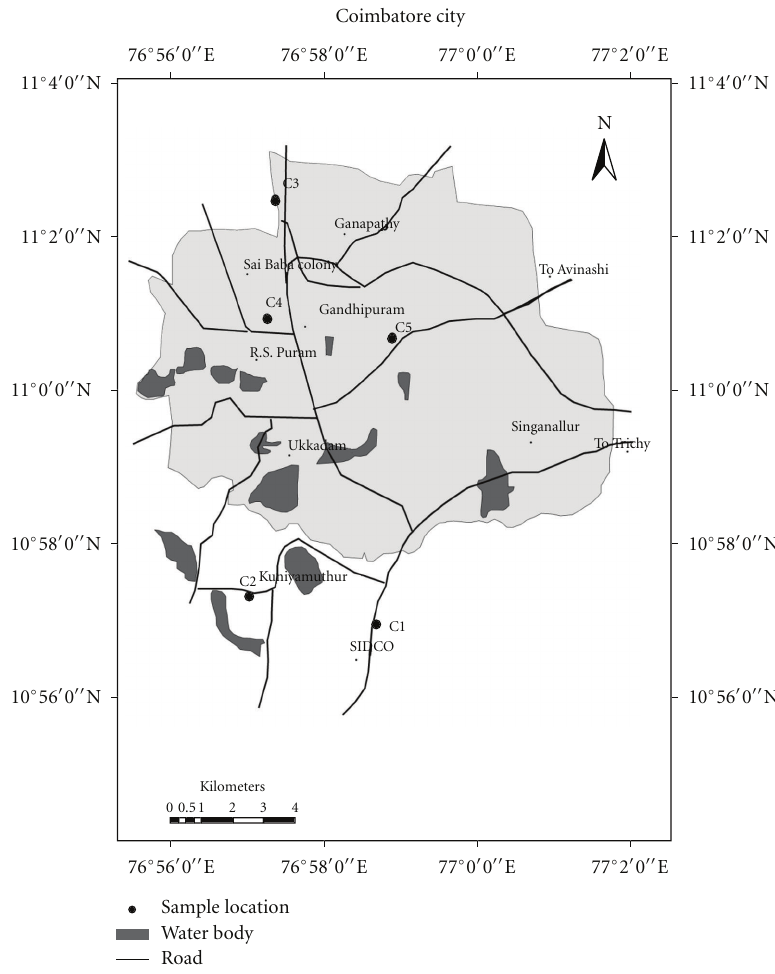
Figure 1: Map showing study sites in